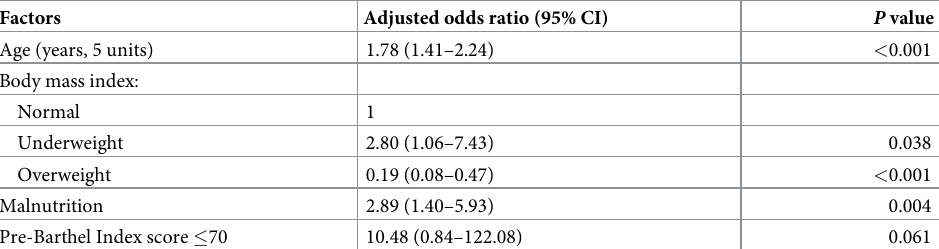
Table 3. Independent risk factors associated with preoperative